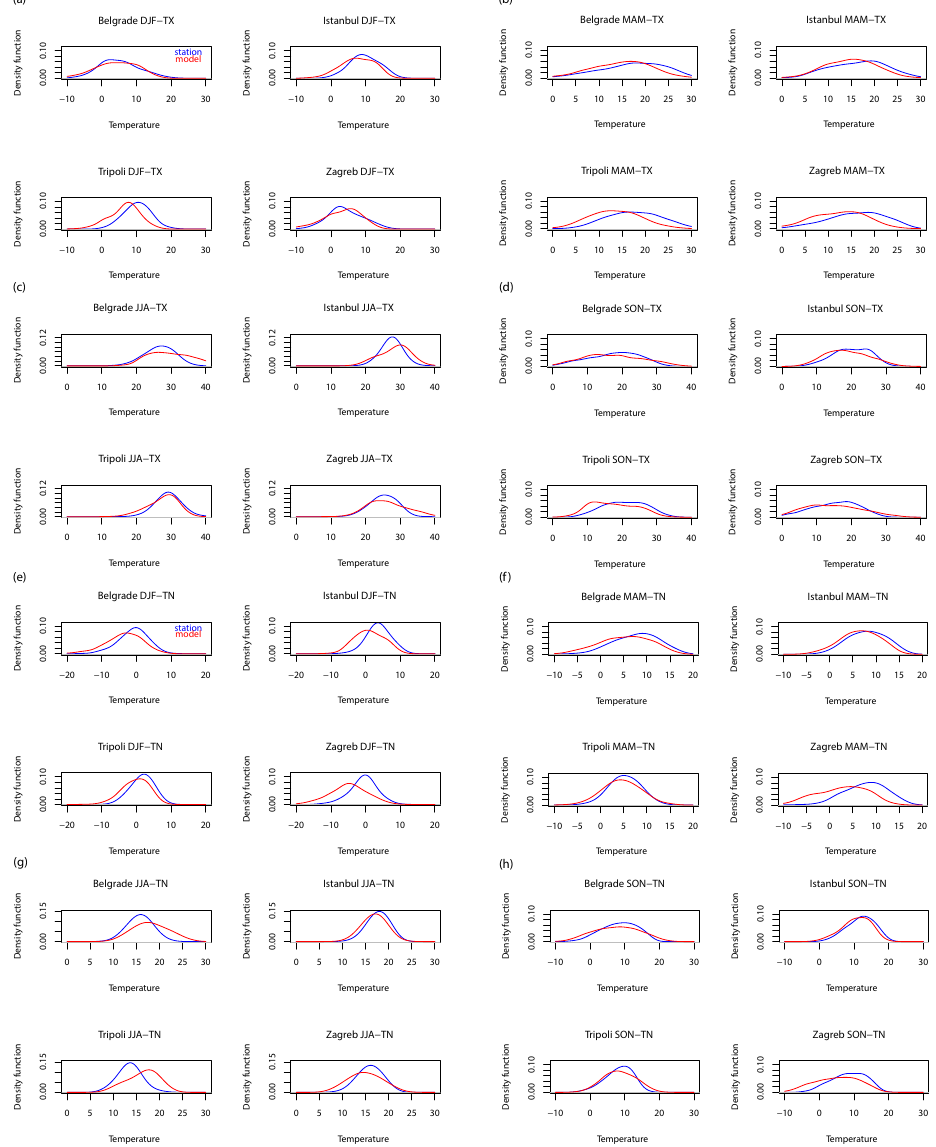
Figure 2. Kernel density estimation of seasonal (winter: DJF, spring: MAM, summer: JJA, autumn: SON) maximum (TX) and minimum (TN) temperature, using station (blue colour) and model (red) data, in four representative